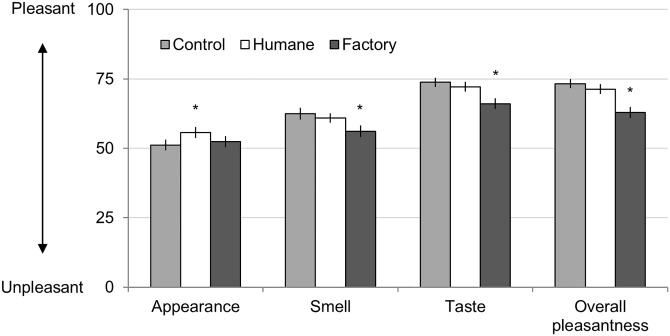
Study 3: Ratings of Ham Sample.Error bars represent standard errors, and asterisks represent significance (* p < 0.05). All ratings made on 100-point slider scales.